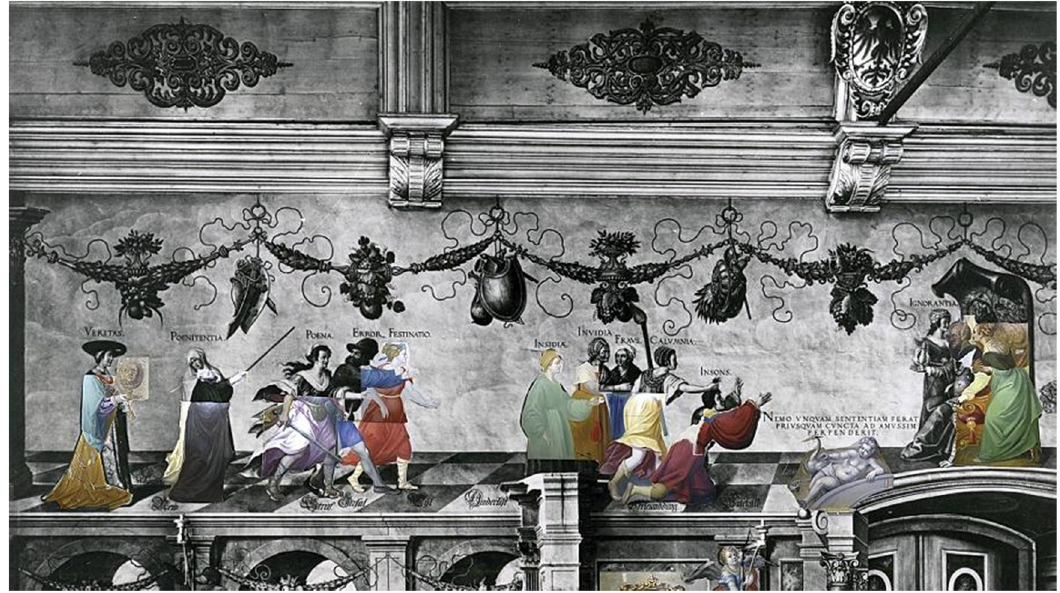
Figure 7: Albrecht Dürer, Die Verläumdung des Apelles , 1521 – 22. Nürnberg: Rathaussaal. Multiply repainted, 1613 and 1904/ 1905. Destroyed ( bomb strike ) , 1944/1945. Public domain.